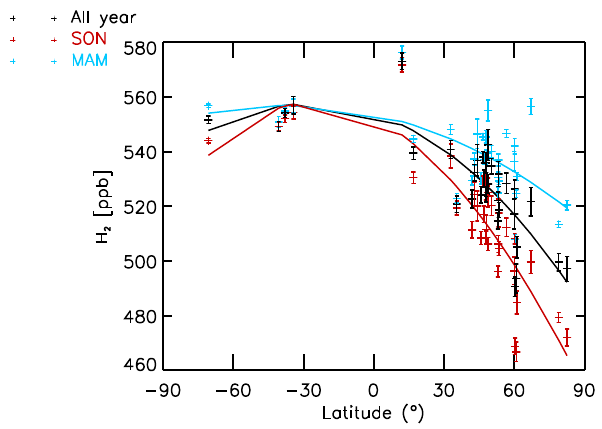
Fig.3. H 2 meanmixingratiolatitudinalgradient. Inblack,forthewholeyear,inblue,forMarch,April, Fig. 3. H 2 mean mixing ratio latitudinal gradient. In black, for the May(MAM)andinredforSeptember,OctoberandNovember(SON). whole year, in blue, for March, April, May (MAM) and in red for 37 September, October and November